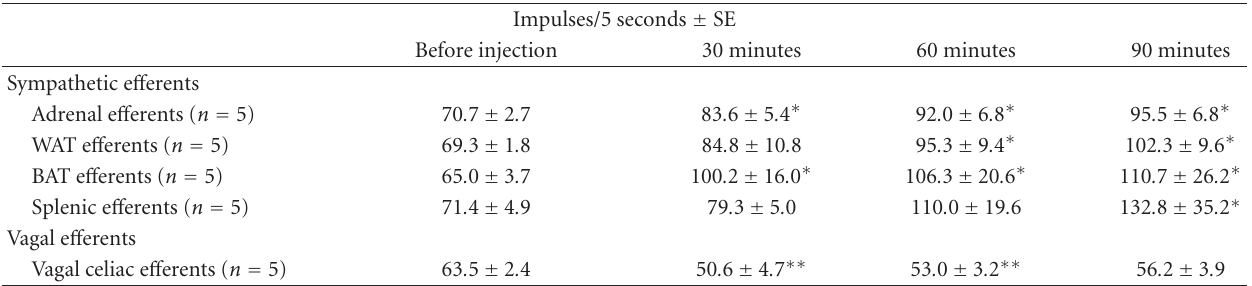
Table 2: Reflex responses of sympathetic and vagal e ff erents following IV injection of leptin (lng,